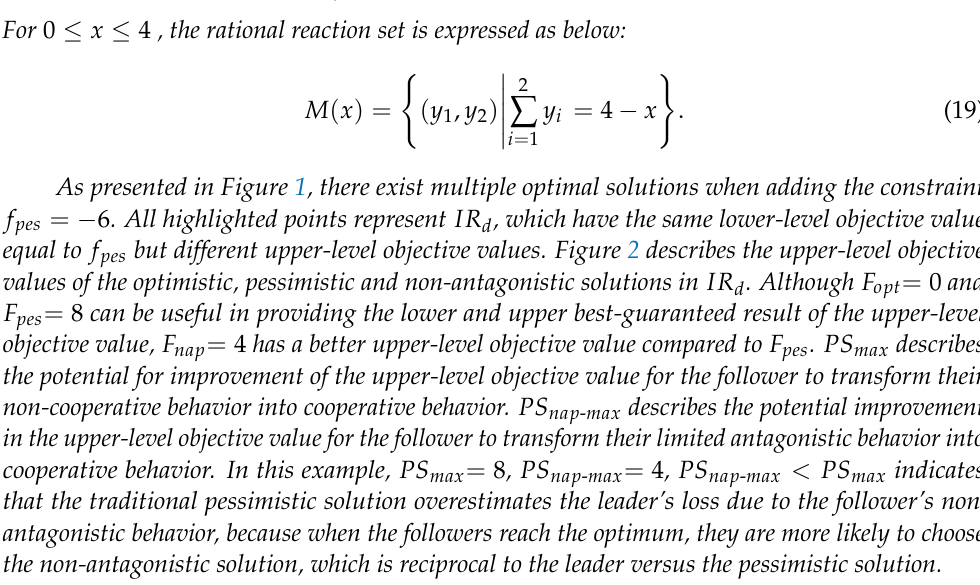
Figure 2. The values of optimal solutions in the upper-level value space of Example 1. Table 1 lists the fi ve types of solutions of Example 1. In this example, ( F nap , f nap ) is not inferior to ( F opt , f opt ). It can also be interpreted that if a fully cooperative follower cannot be observed, the non-antagonistic solution would be the expected result of the leader’s practical goal. Furthermore, ( F rew , f rew ) has the same value as ( F nap , f nap ) due to x rew = x nap , while ( F dec , f dec ) is dominated by the rest of the optimal solutions. More discussion about this will be included in the following example. Table 1. The solutions and optimal values of Example 1. Example 1